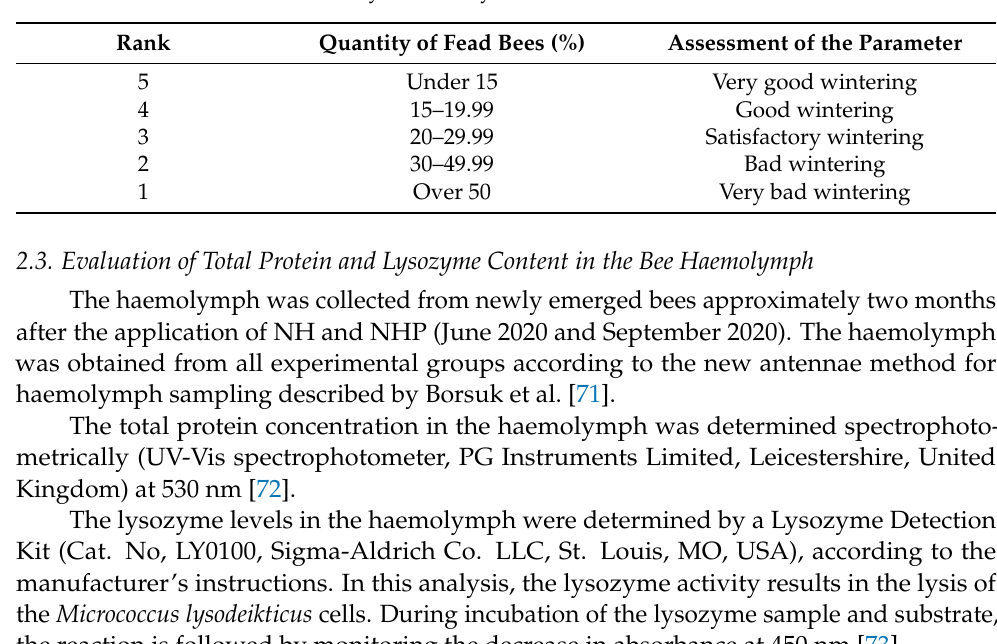
Table 2. Assessment of winter honey bee colony